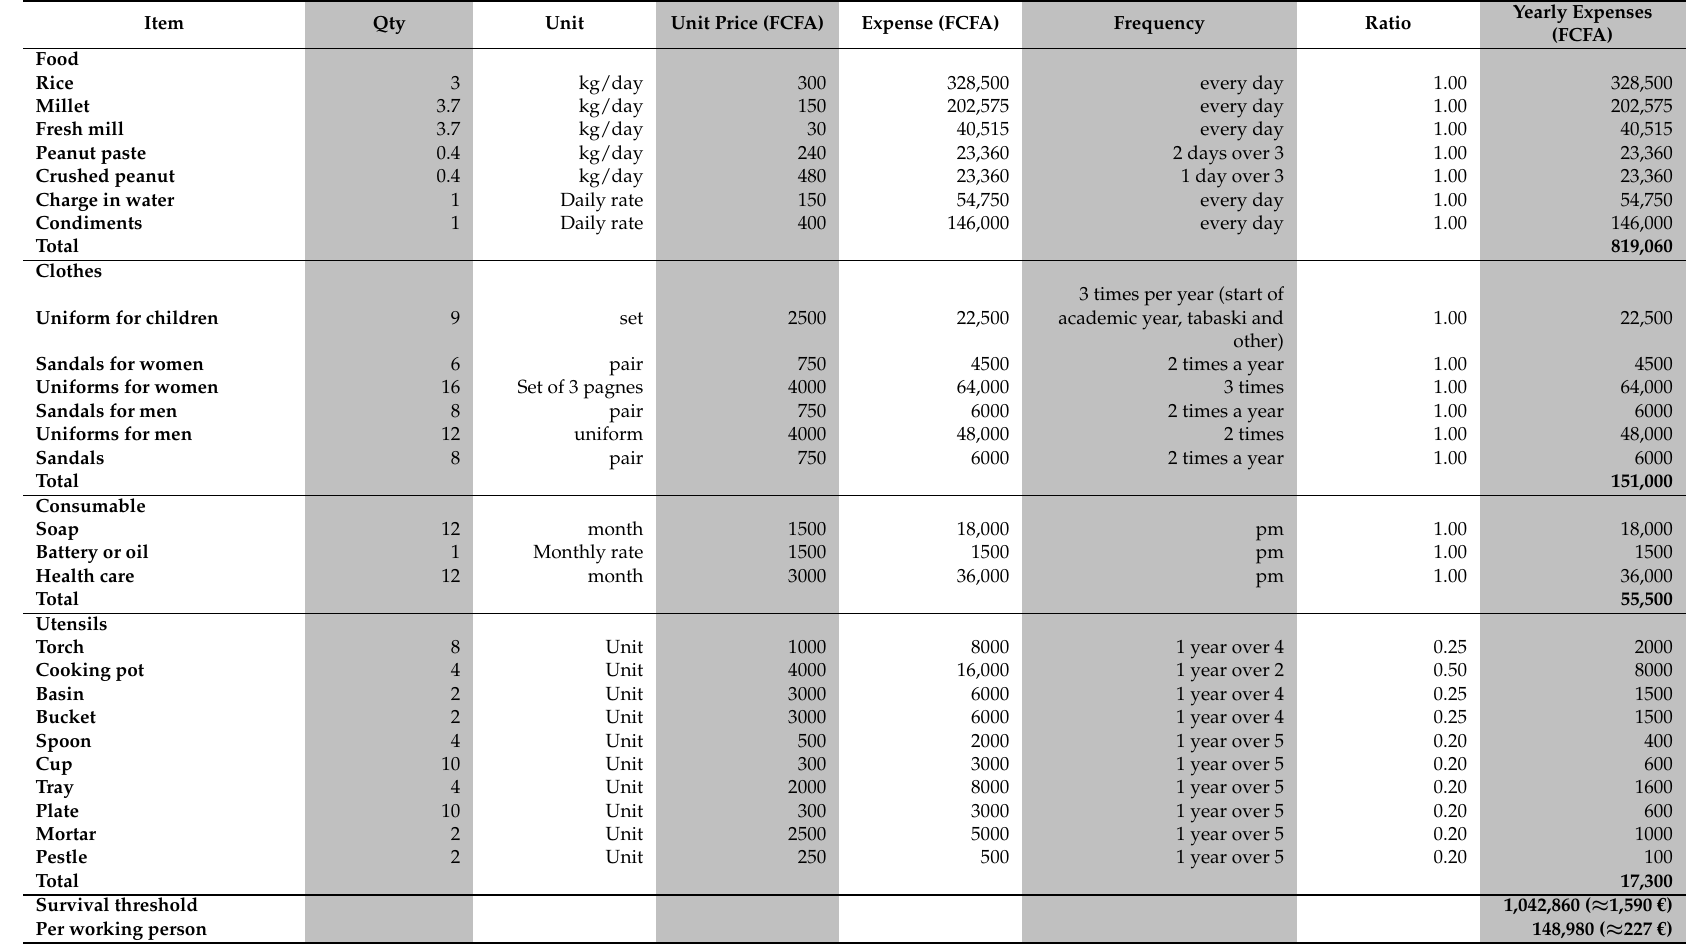
Table 3. Model of the survival threshold for a family composed of seven working people, two retired persons, and three